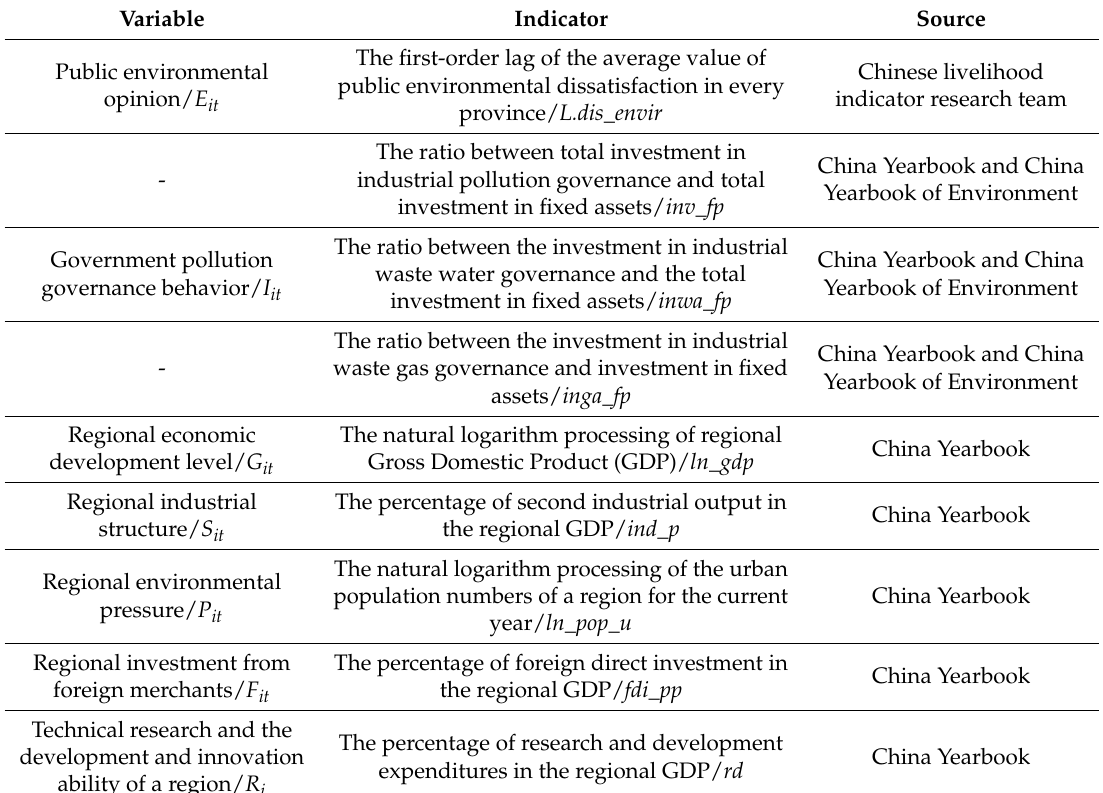
Table 2. Data Collecting and